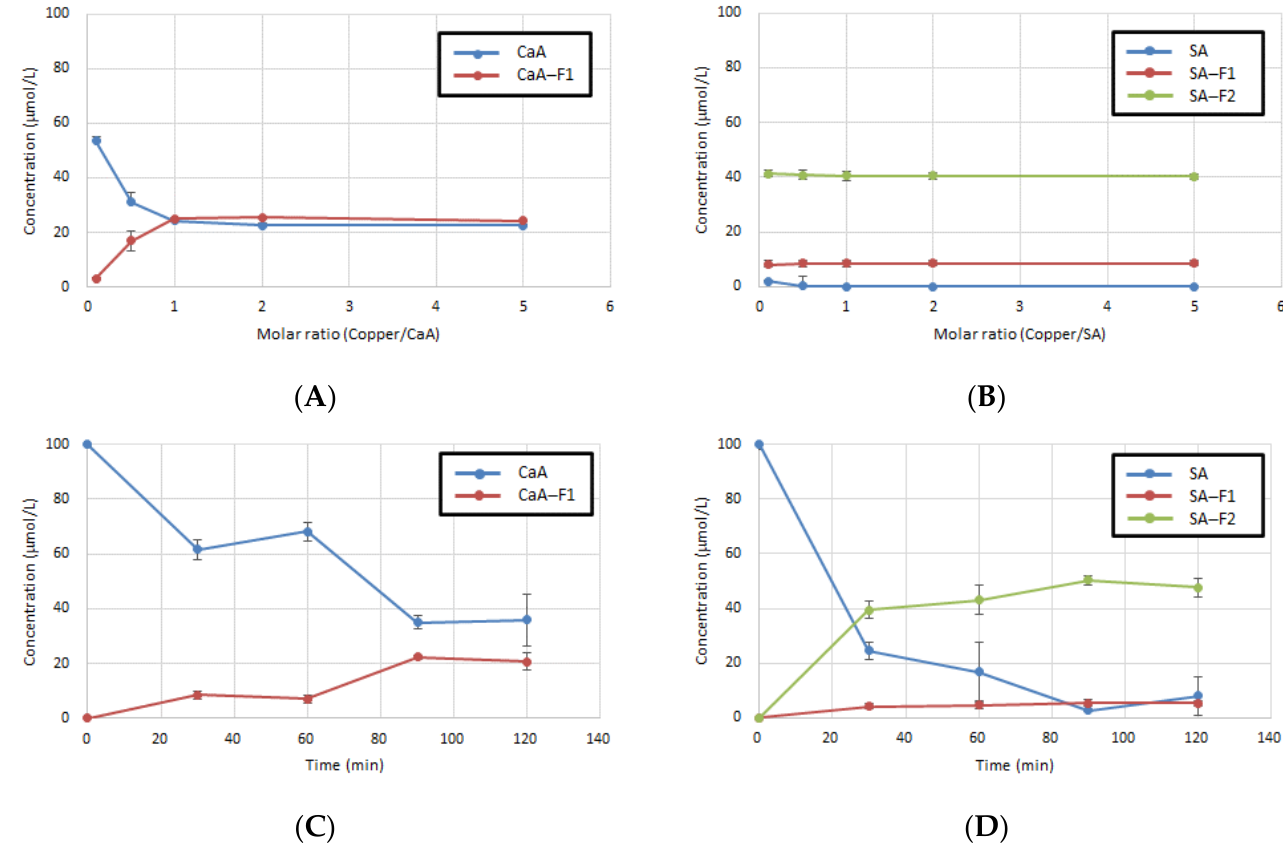
Figure 5. Comparative reaction conditions of CaA or SA with copper ions in FaSSIF. ( A ) Molar ratio of CaA for 60 min at 37 °C; ( B ) molar ratio of SA for 60 min at 37 °C; ( C ) time course of CaA at 37 °C; and ( D ) time course of SA at 37 °C. Results are presented as the mean ± SD for three independent experiments.